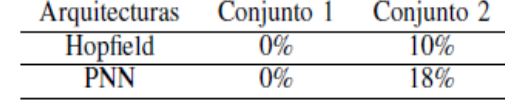
Tabla 1: % de error de clasificación n con entrenamiento con validación Cruzada.